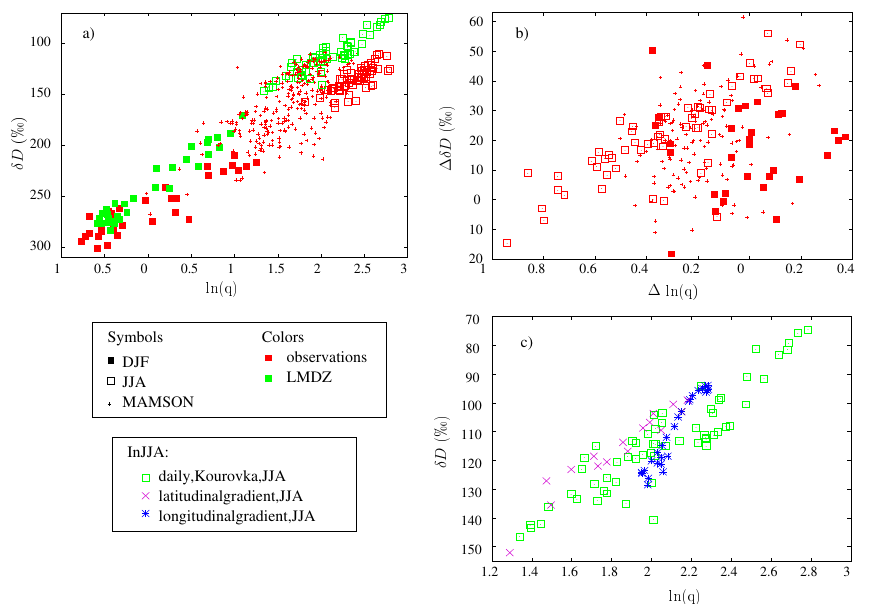
Fig. 13. (a) δD as a function of ln ( q ) , in the observed data (red) and in the model (green). (b) ∆ δD as a function of ∆ ln ( q ) . ∆ refers to the model–data difference. Symbols refer to the season: December–January–February (filled squares), June–July–August (empty squares) and March–April–May–September–October–November (crosses). (c) Comparison of the simulated δD -ln (q) relationships in JJA in the near- surface vapor for the different days at Kourovka (green squares), for different latitudes at the longitude of Kourovka (magenta crosses) and for different longitudes at the latitude of Kourovka (blue stars). Table 9. Characteristic of the daily δD -ln (q) distribution in JJA for the LMDZ simulation, for the different LMDZ-ORCHIDEE sensitivity tests listed in Table 1 and for in situ observations. The “ δD values for ln (q) = 2 . 5” are calculated as 2 . 5 · a + b where a is the slope (given in the first column) and b is the intercept of the linear regression. This gives an idea of the systematic offsets between the different simulations when plotted in the δD -ln (q) diagram. The uncertainty on the slopes is about 6‰. Model Slope of δD vs. JJA-mean